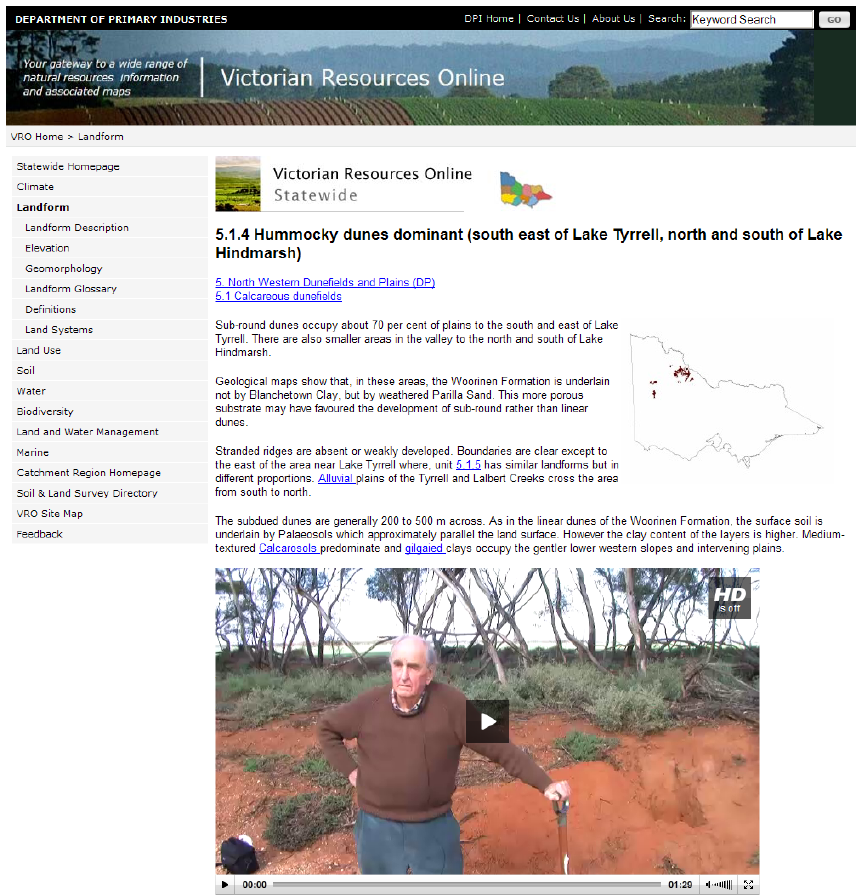
Figure 17. Webpage incorporating video of a retired regional expert (Jim Rowan) discussing soil and landscape features in the Mallee region.  State of Victoria, Department of Primary Industries 1997 Reproduced with